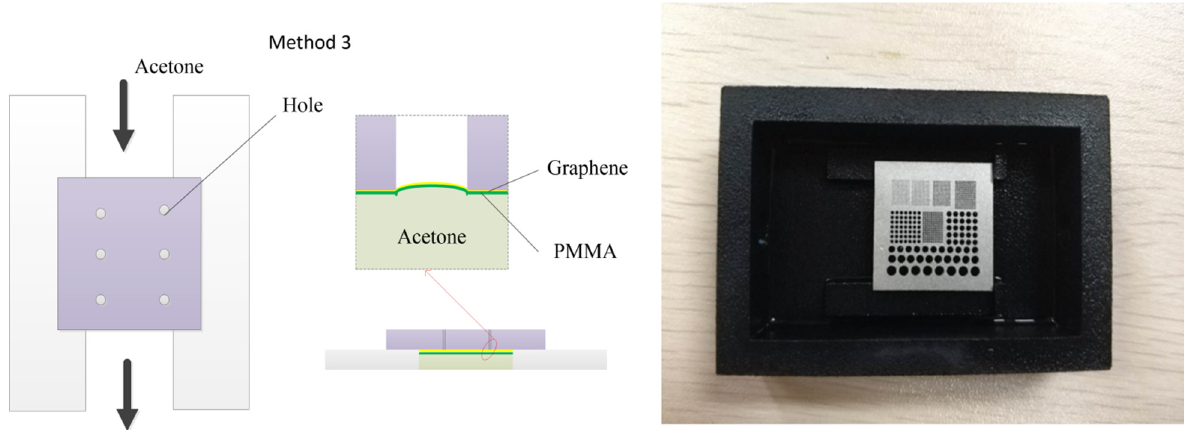
Figure 7. The schematic diagram of the PMMA removal by the inverted floating method (IFM) method.